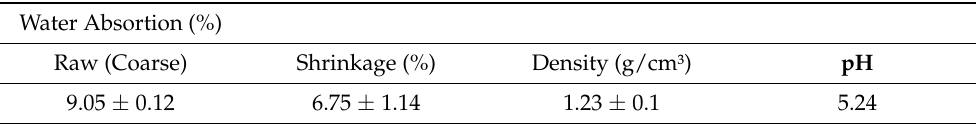
Table 6. Physical properties of the crushed